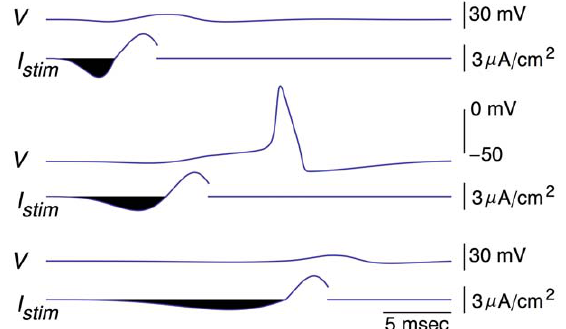
Figure 4. Effect of changing the duration of the hyperpolariz- ing phase of the biphasic stimulus on firing while keeping the square of the area of this phase constant. Middle panel: I stim = f ( t )= a sin(( bt ) 2 ) (exp( ct ) 2 1) with a =563 m A/cm 2 , b =0.2 msec 2 1 , and c=0.00045 msec 2 1 . These same values of a , b , and c were used for the depolarizing phase of f ( t ) in the top and bottom panels, respectively, with the time at the beginning of this phase chosen to match the end of the preceding hyperpolarizing phase. In the top panel, a =1320 m A/cm 2 and b=0.35 msec 2 1 for the hyperpolarizing phase (c=0.00045 msec 2 1 throughout all simulations). In the bottom panel a =201 m A/cm 2 2 and b =0.1 msec 2 1 for the hyperpolarizing phase. These values of a were chosen so that the square of the area of the hyperpolarizing phase (shaded black in all 3 panels) was maintained constant as determined using the NIntegrate function in Mathematica.